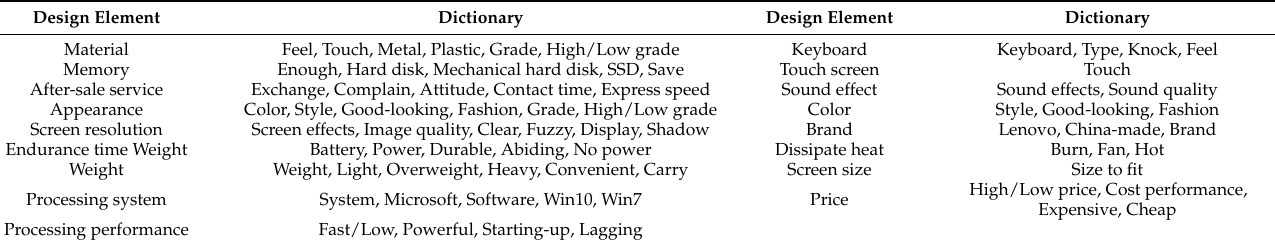
Table 4. User-defined design element